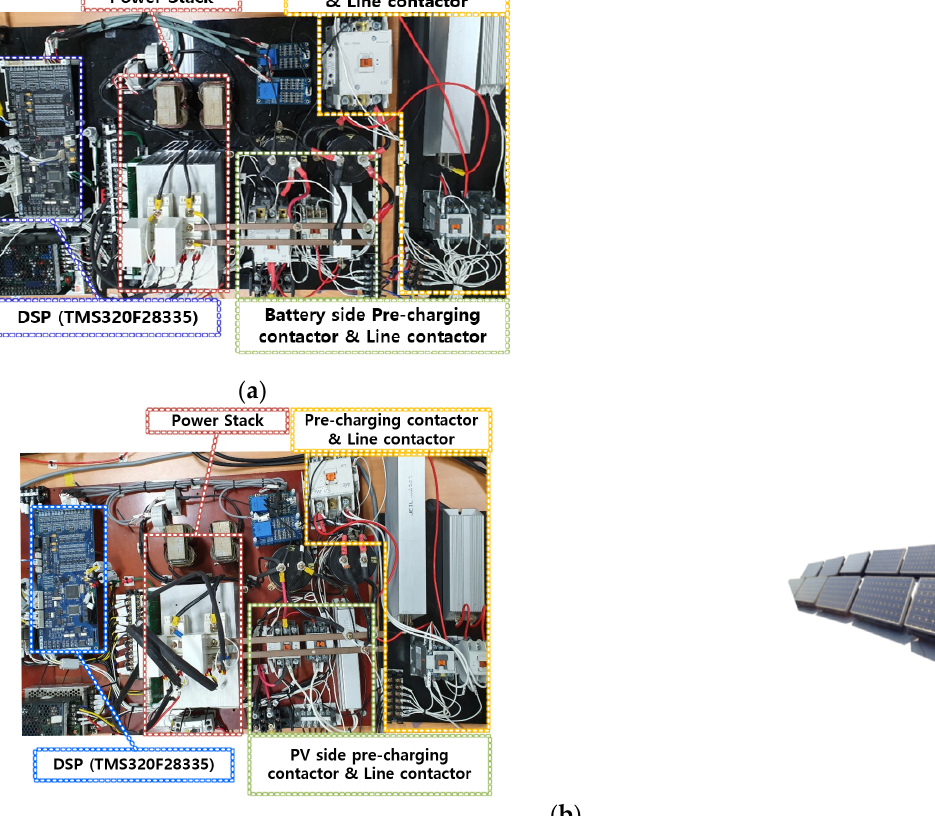
Figure 18. Configuration of the hardware set for ESS and PV ( a ) converter for ESS, ( b ) converter for PV.